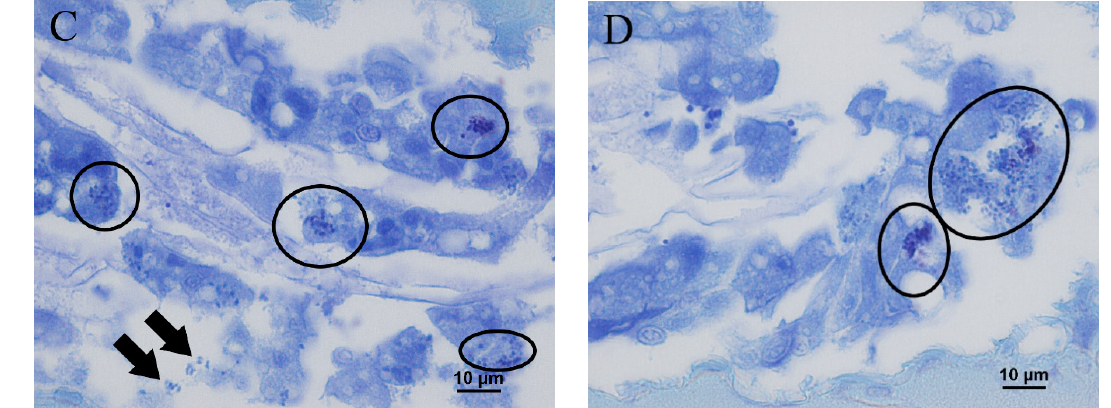
Figure 3. Hepatopancreas of Pacific whiteleg shrimp infected with EHP. ( A , B ) Hematoxylin and eosin staining revealing numerous eosinophilic EHP in the cytoplasm of epithelial cells in the hepatopancreas (ellipses) and edema in the interstitial tissue (asterisk). ( C , D ) Giemsa staining revealing numerous EHP (purple) in the cytoplasm of epithelial cells in the hepatopancreas (ellipses), along with EHP released into the lumen of the digestive tubule (arrows).